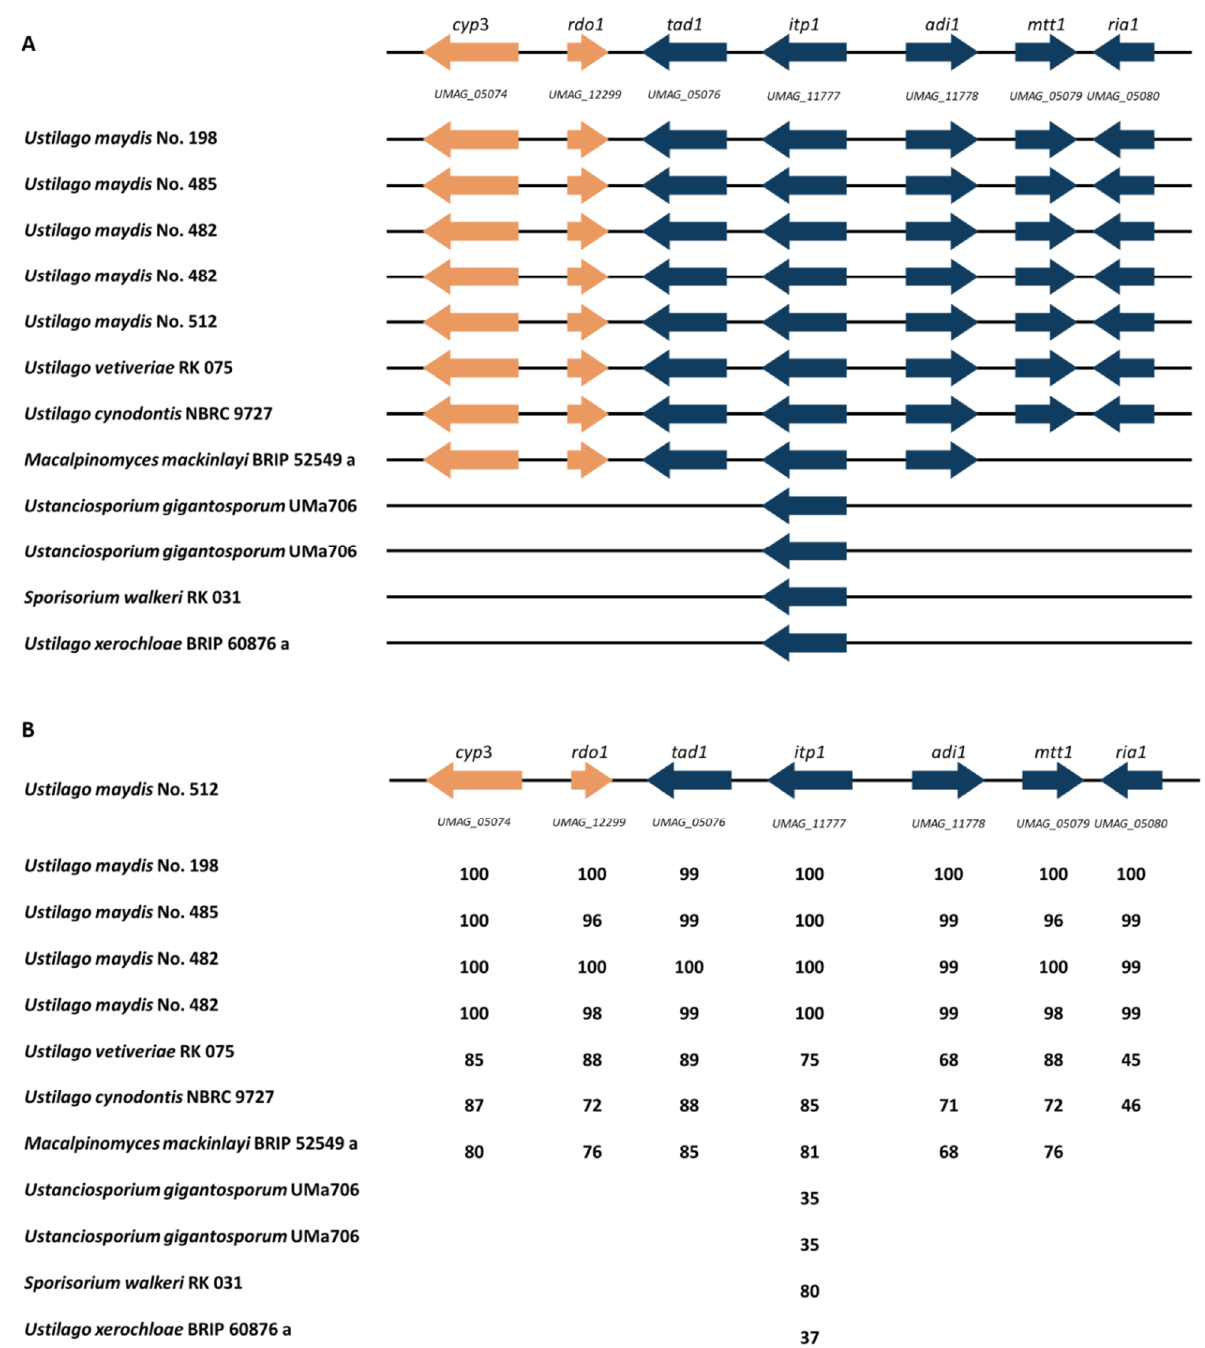
Figure 6. Schematic overview of the itaconate biosynthesis gene cluster in U. maydis . Modified from [65] ( A ): Organization of the cluster genes is compared to the sequenced Ustilaginaceae isolates. Blue color indicates genes directly involved in itaconate production and transport [13]. Orange-colored genes are involved in itaconic acid conversion into its derivates [14]. Cyp3 (P450 monooxygenase), rdo1 (glyoxalase domain-containing protein RDO1), tad1 (trans-aconitate decarboxylase 1) itp1 (itaconate transport protein), adi1 (aconitate-delta-isomerase 1), mtt1 (mitochondrial tricarboxylate transporter 1), ria1 (regulator of itaconic acid biosynthesis). ( B ): Itaconate cluster com- parison of selected Ustilaginaceae. Numbers given show amino acid sequence identity as percentage compared to the reference strain U. maydis No. 512 using antiSMASH 6.0 [58]. Two isolates were sequenced in the case of U. maydis No. 482 and U. gigantosporum